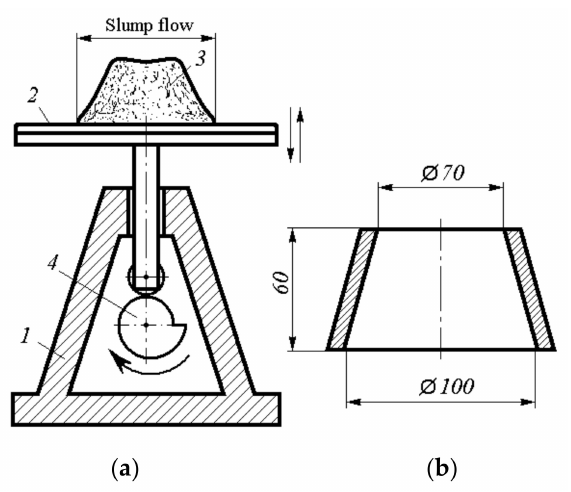
Figure 1. Flow table ( a ) and cone mould ( b ) for flow table test for mortar: 1 is base, 2 is flow table, 3 is cone from mortar, 4 is tappet.